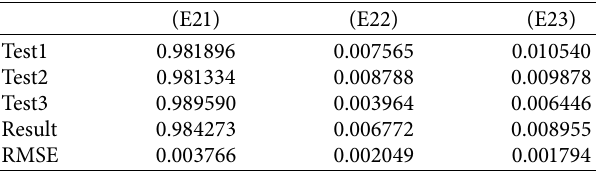
Figure 11: Proportion of each index of closed straight section. Table 4: Proportion of each index of closed curve